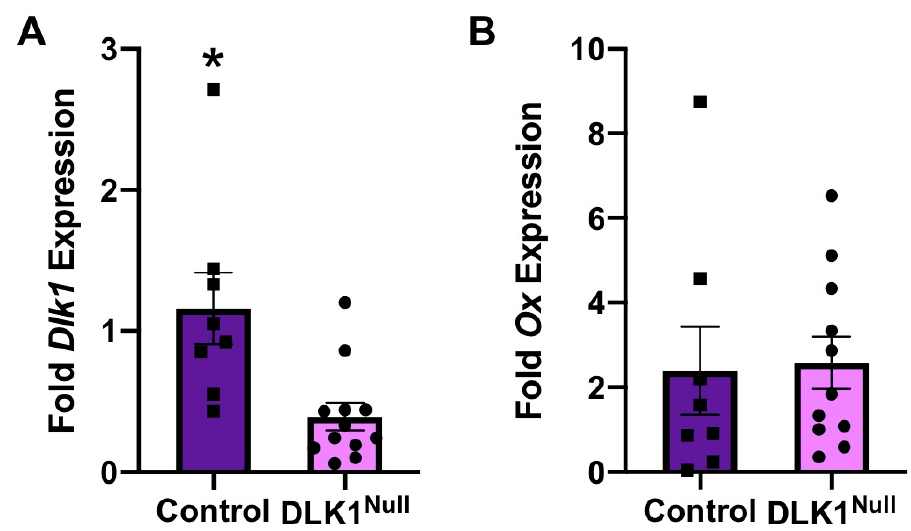
Figure 3. LHA-specific deletion of DLK1 in adult mice. ( A ) DLK1 Flox/+ mice received bilateral LHA injections of either AAVeGFP (yielding Control mice with intact DLK1) or AAVcreGFP (to yield mice with cre-lox mediated deletion of DLK1 from the LHA, DLK1 Null mice). ( B ) Immunofluorescence for DLK1 (red) in the LHA confirms intact DLK1 in Controls compared to significant reductions in DLK1 in DLK1 Null mice by 2 weeks after AAV injection ( n = 3). ( C ) Analysis at the end of the metabolic and behavioral phenotyping (30–42 weeks post-surgery) confirms that Control mice retain DLK1 expression, but DLK1 Null mice lack DLK1 expression in the LHA. ( D ) OX immunoreactivity remains intact within the LHA of Control and DLK1 Null mice at the end of the study. For ( C , D ), Control n = 7, DLK1 Null = 15.